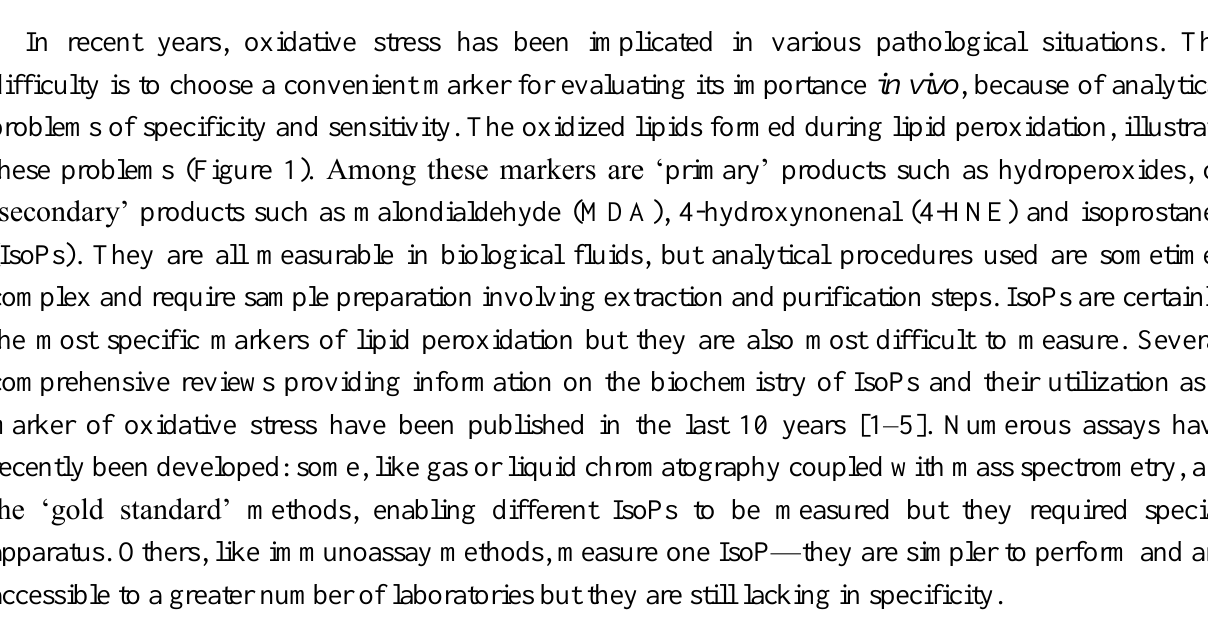
Figure 1. Main products of Reactive Oxygen Species